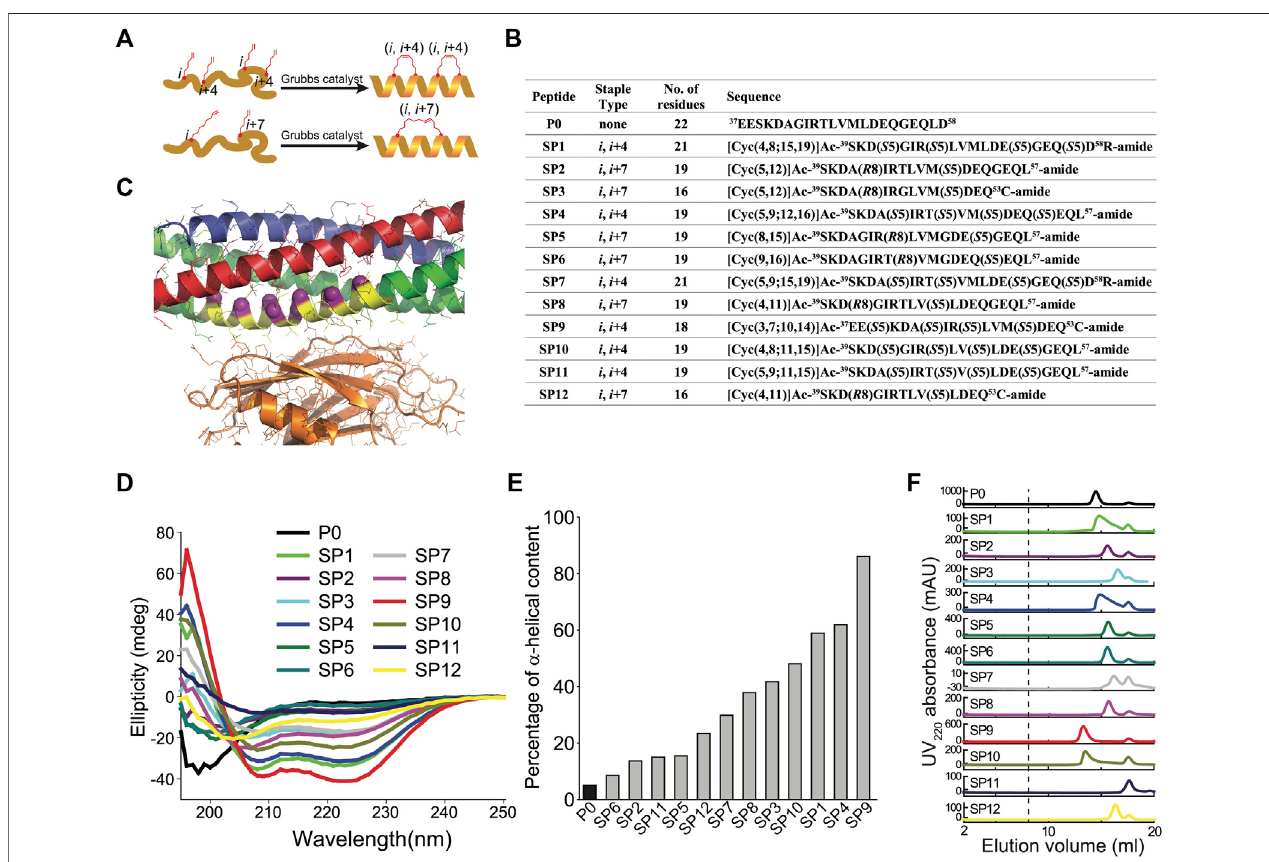
FIGURE1| Design andcharacterization ofstapled peptides. (A) Schematicdiagramforstapledpeptides synthesis. Hydrocarbon-stapledpeptides areformed via cross-linkingtheresiduesatthespeci fi edpositions.P0isthewildtypesequenceforSNAP-25A,residues37 – 58. (B) Designofsynthesizedstapledpeptideswithvarying lengthsofole fi nicsidechainsanddifferentpositionsofthenon-naturalaminoacidsubstitutions.ThesuperscriptsspecifythestartingandendpositionswithintheSNAP- 25A sequence. Sn or Rn indicates S or R stereochemistry at the α -carbon, respectively, n indicates the number of carbon atoms in the ole fi nic side chains. (C) Close-up view of the primary interface between the neuronal SNARE complex (VAMP-2 — blue, Stx1 — red, SNAP-25A — green) and the C2B domain of Syt1 (orange) (PDB ID 5W5C), indicating the region (yellow) from which the peptides were chosen. The C α -positions of the S5 and R7 non-natural amino acid substitutions of all the designs are indicated by purple spheres. (D) CD spectra of the speci fi ed peptides measured at 100 mM concentration, pH 7.4, 25 ± 1 ° C. (E) Percentage of α -helical content of the speci fi ed peptides as estimated by dividing the mean residue ellipticity ( φ ) 222 obs by the reported ( φ ) 222 obs for a model helical decapeptide. (F) Size exclusion chromatography (SEC) pro fi les of the speci fi ed peptides. Each peptide was fi ltered with a 0.2 μ m fi lter and then loaded on a Superdex 75 column in buffer V (20 mM HEPES, pH 7.4, 90 mM NaCl). The dashed line indicates the border of the void volume at ~8 ml.